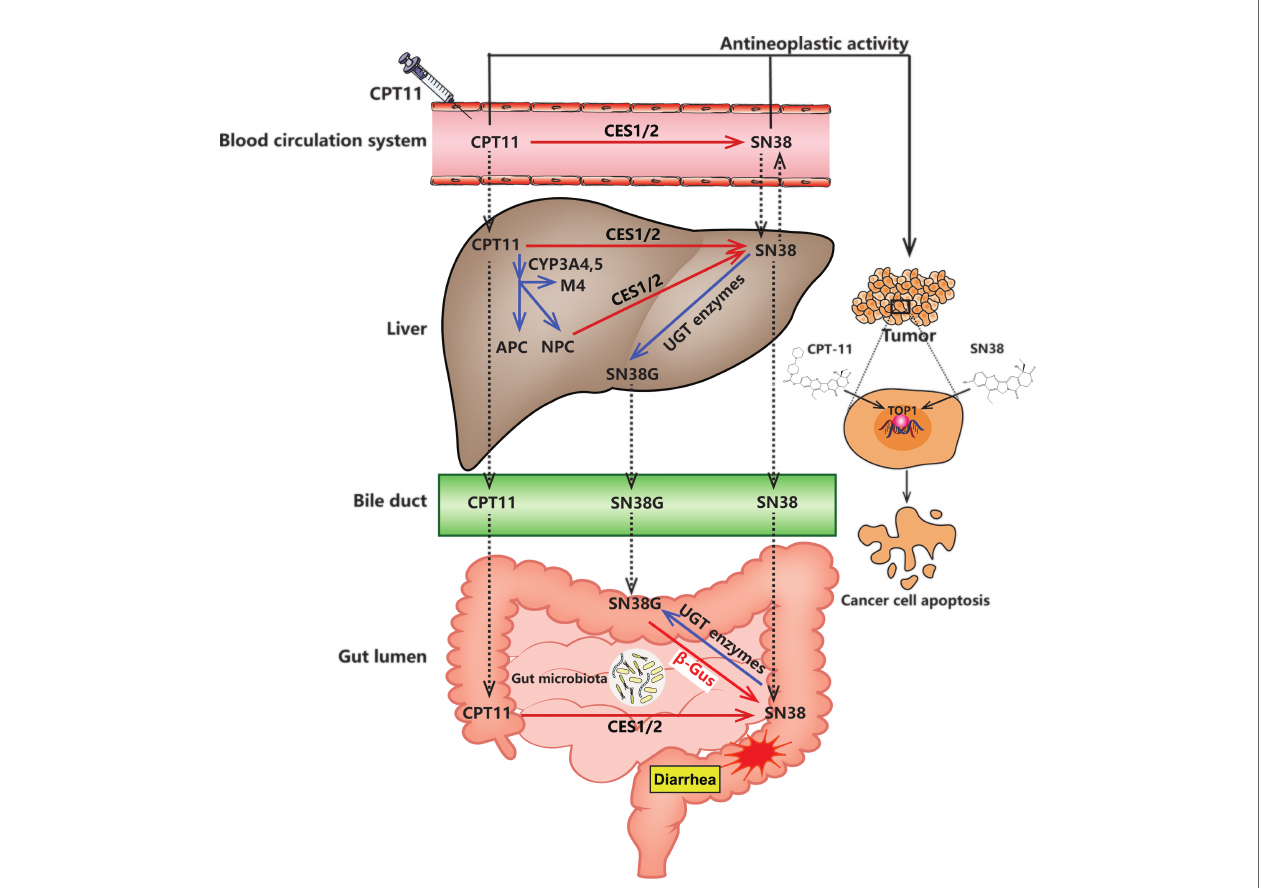
FIGURE 1 | CPT11 metabolism and excretion in the human body. The deactivation and activation of compounds (CPT11 or SN38) are represented by blue and red arrows, respectively. CPT11 induced delayed diarrhea are represented by red stellate symbol. The black solid arrows indicate the antineoplastic activity of CPT11 and SN38. The transport of CPT11 and its metabolites (SN38 and SN38G) between the blood circulation system, liver and gut lumen are pointed out by dashed-line arrows. CES1/2, carboxylesterase 1/2; APC, 7-ethyl-10-(4-N-(5-aminopentanoic acid)-1-piperidino) carbonyloxy-camptothecin; NPC, 7-ethyl-10-(4-amino-1- piperidino) carbonyloxy-camptothecin; CYP3A4, cytochrome P450; UGT, UDP-glucuronosyltransferase; b -Gus, b